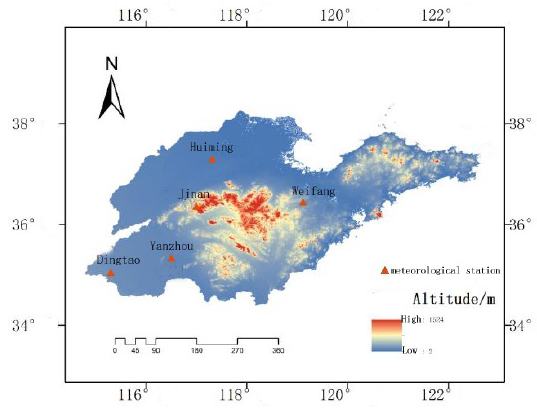
Figure 1 location of study area and meteorological